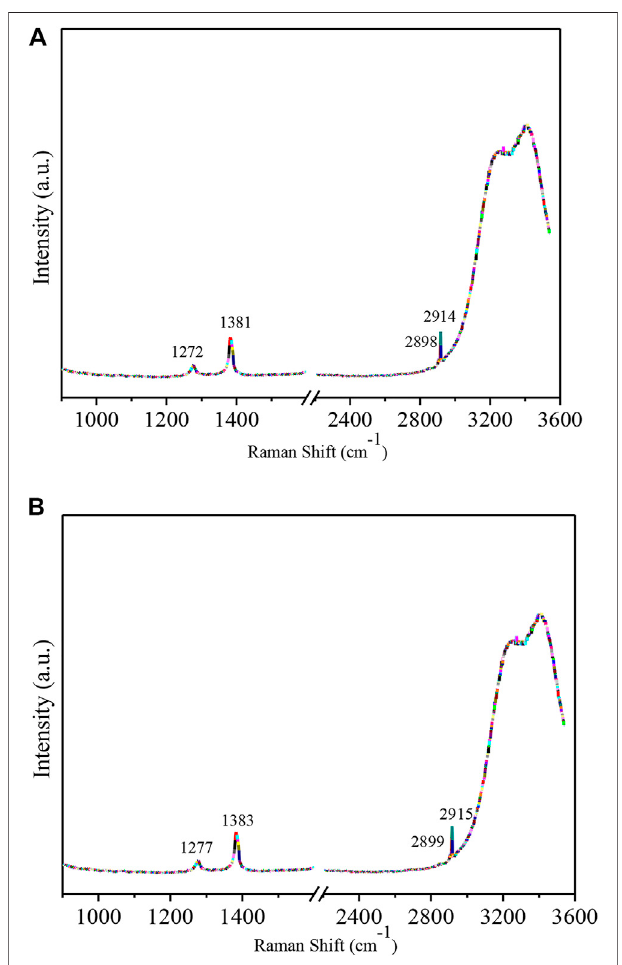
FIGURE 3 | (A) Raman spectra of 70% CO 2 mine mixed-gas hydrates. (B) Raman spectra of 75% CO 2 mine mix8IJed-gas hydrates.